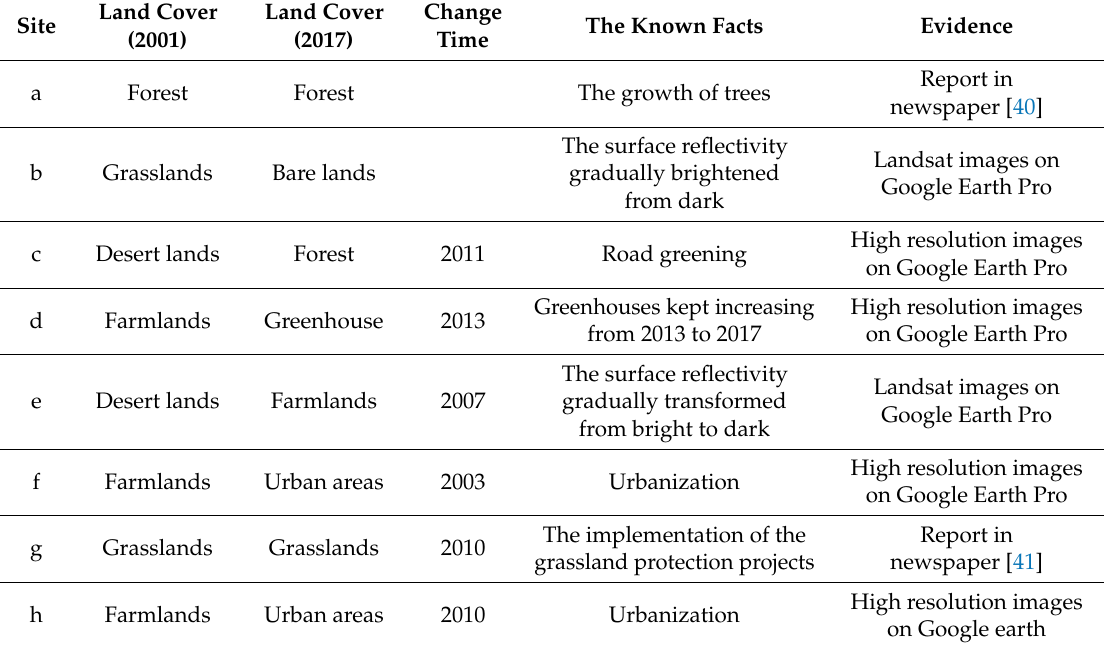
Table 3. Landscape transformations or modifications in the eight reference sites for validation (Figure